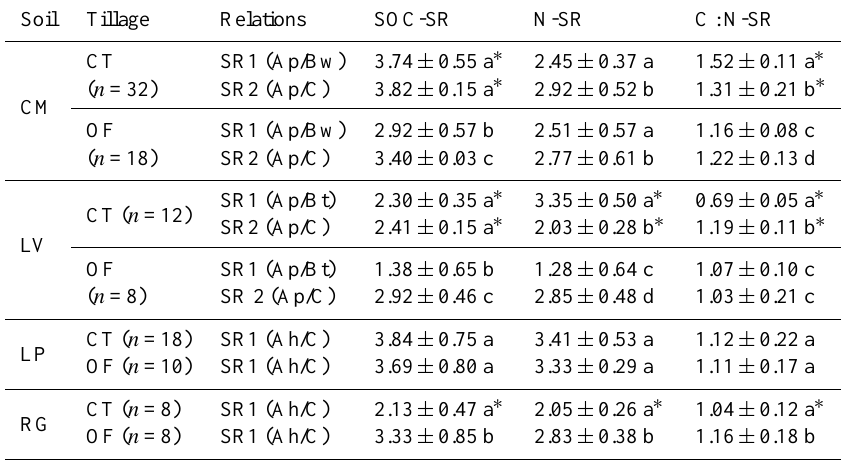
SOC-SR: Stratification ratio of soil organic carbon; N-SR: Stratification ratio of nitrogen; C:N-SR: Stratification ratio of the C:N ratio. CM: Cambisol; LP: Leptosol; RG: Regosol; LV: Luvisol. CT: Conventional tillage; OF: